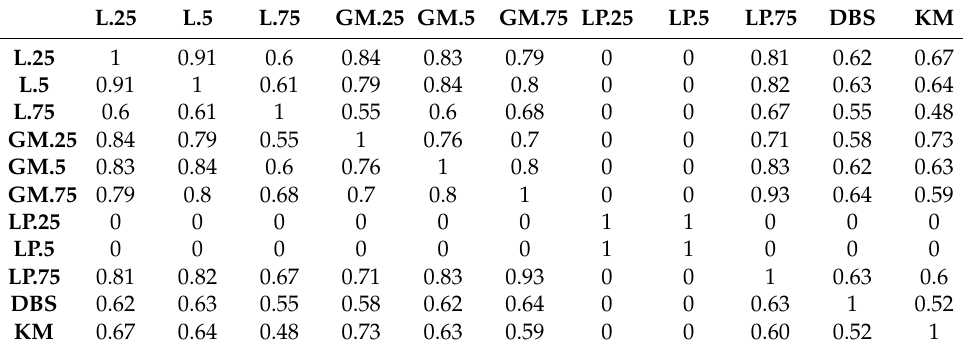
Table 2. NMI index for retail customers clustering.